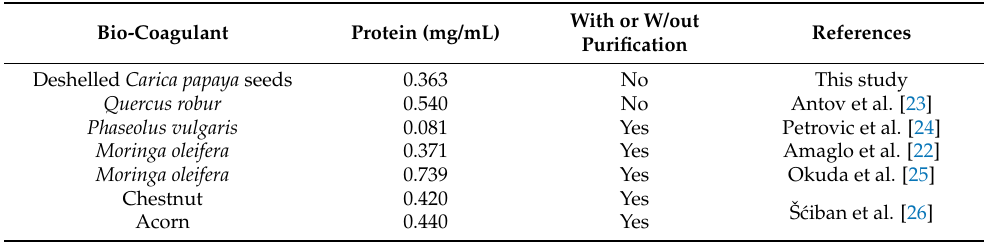
Table 3. Comparison of protein content comprised bio-coagulant deshelled Carica papaya seeds and other